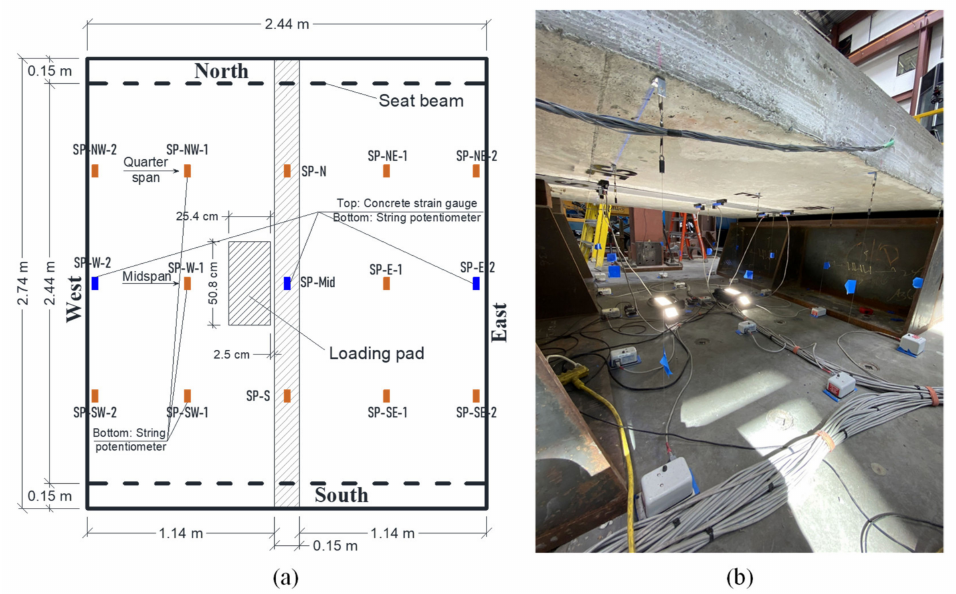
Figure 5. Instrumentation plan ( a ) plan view for the locations of the string potentiometers; ( b ) photograph of the